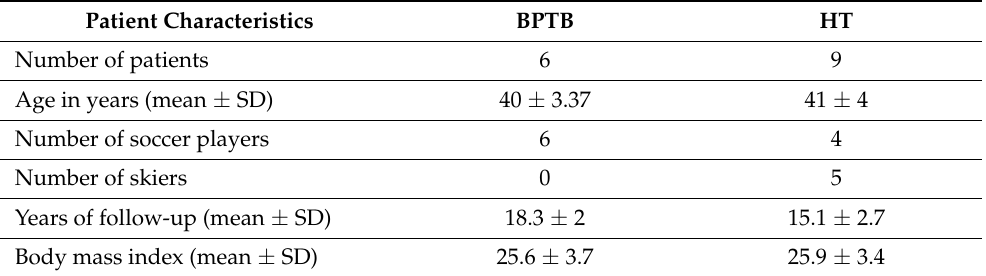
Table 1. Demographic data of athletes separated by graft